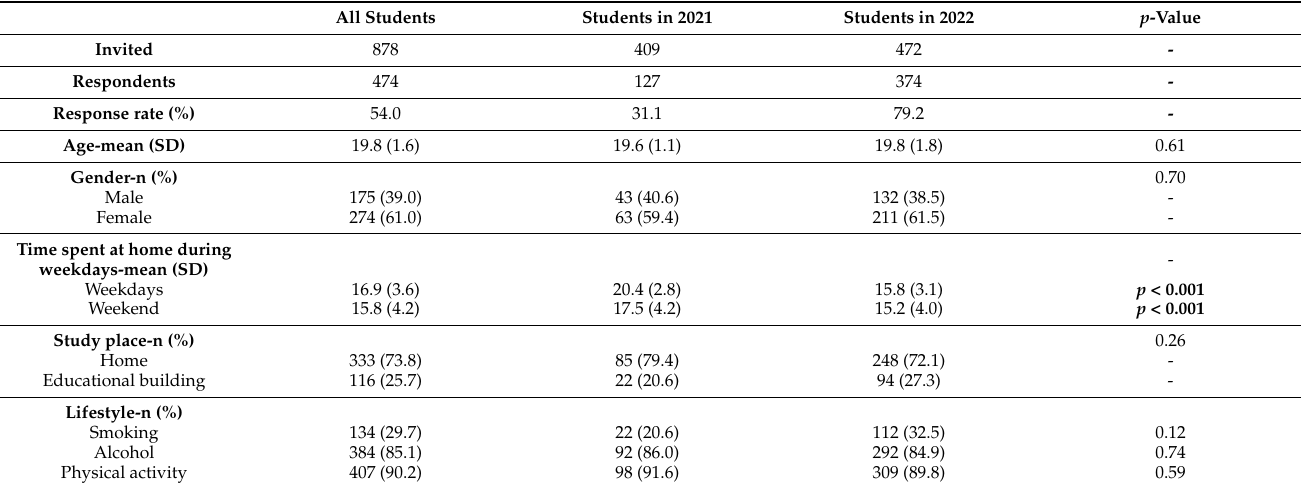
Table 1. Students characteristics in 2021 and 2022.